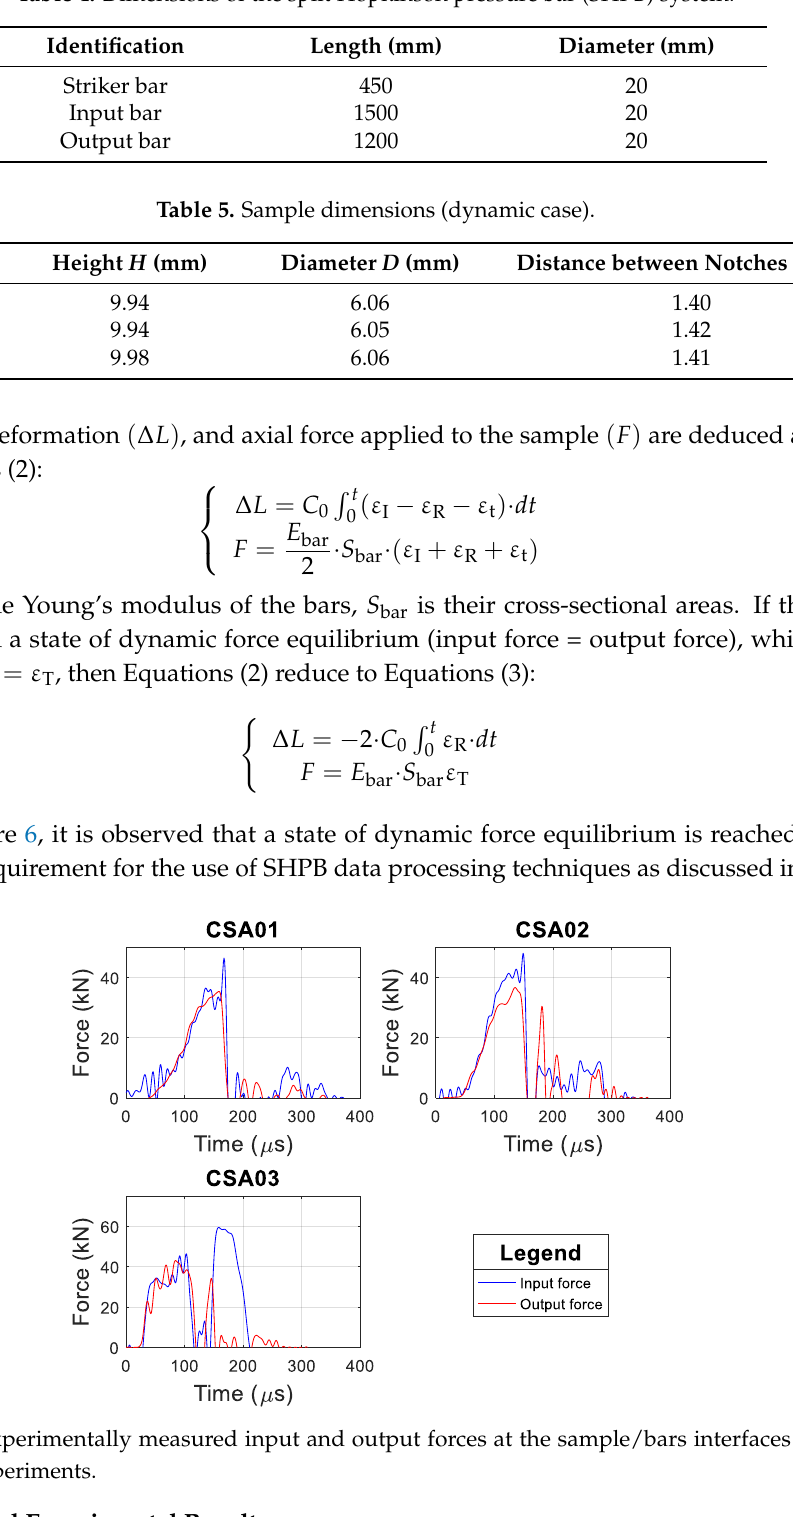
Table 4. Dimensions of the split Hopkinson pressure bar (SHPB) system.